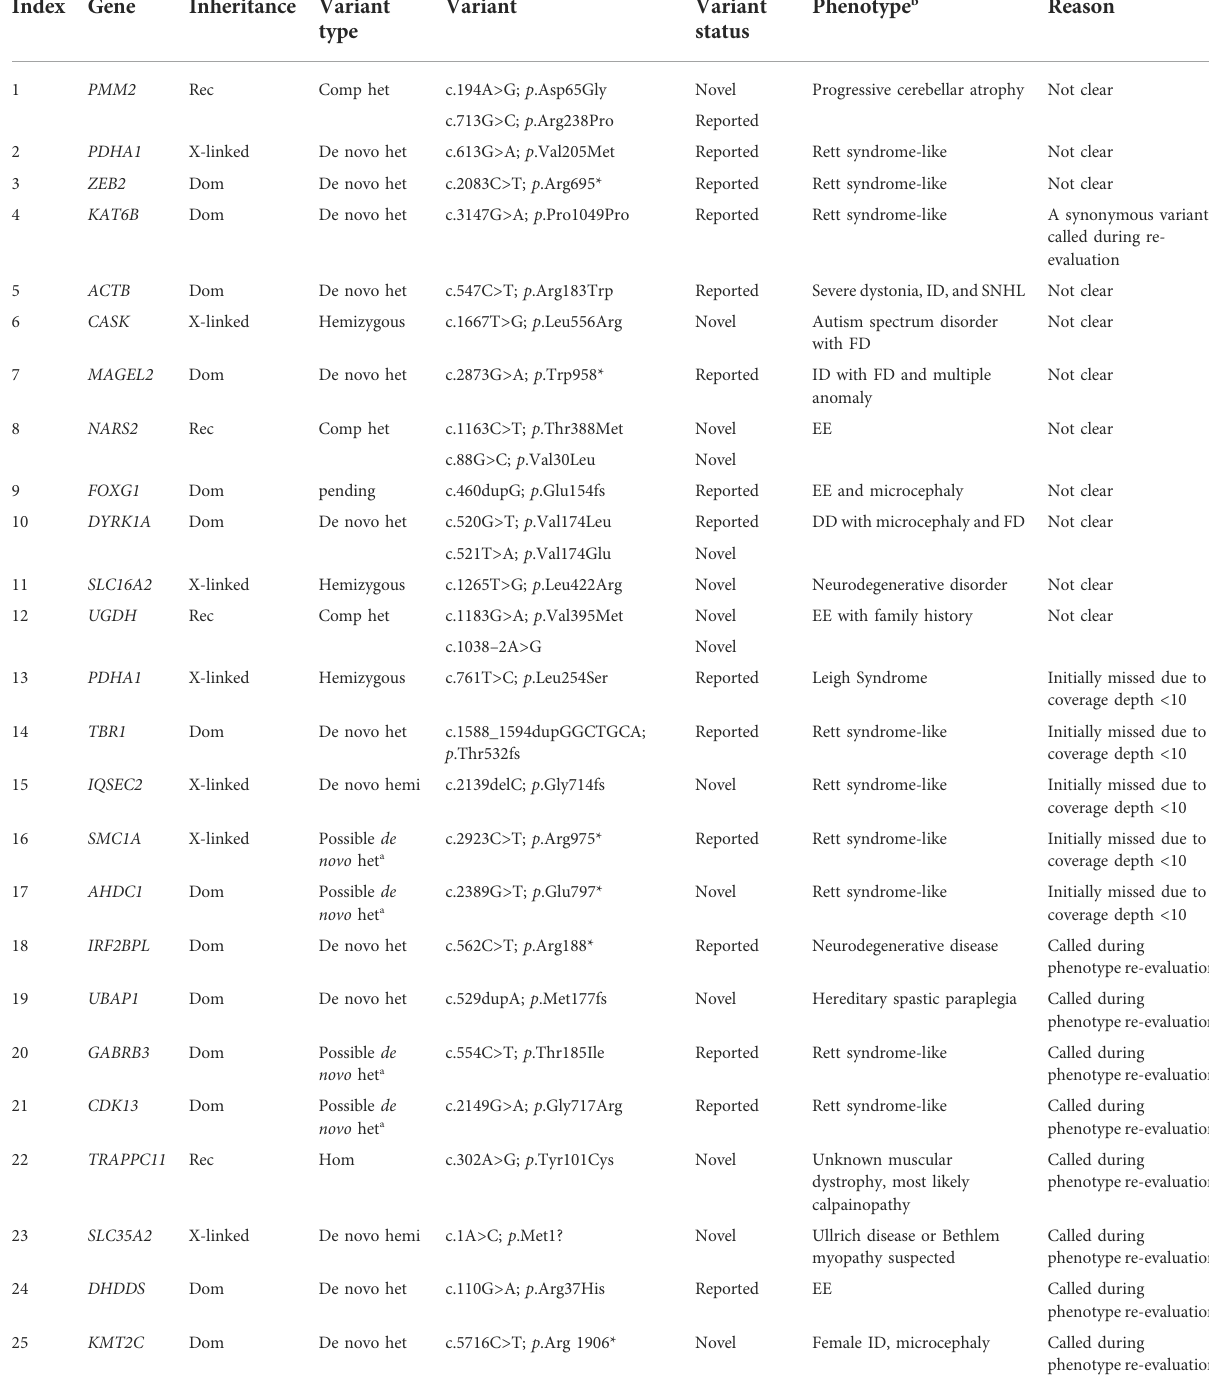
TABLE 2 List of newly diagnosed cases by data